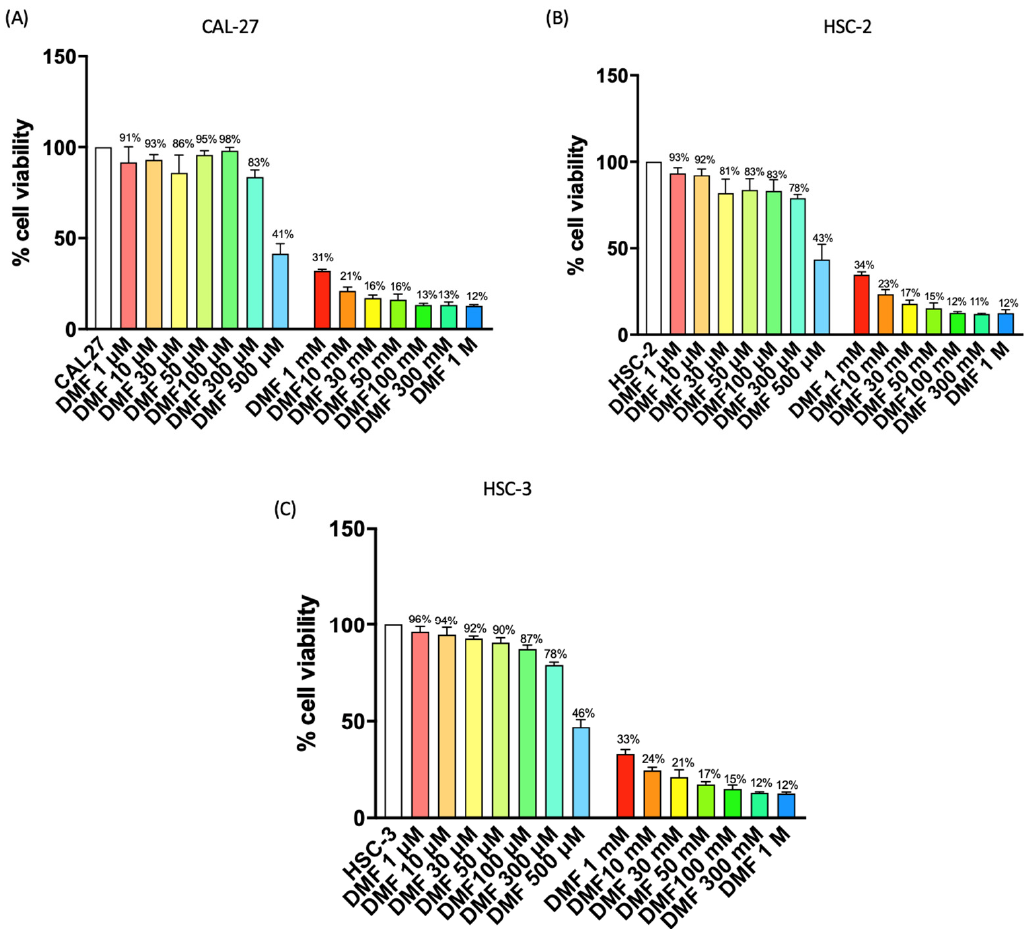
Figure 1. Effect of DMF on CAL27, HSC-2 and HSC-3 cell viability. DMF treatment at the concentrations of 500 μ M was able to significantly reduce cell viability by 41% on CAL27 cells ( A ), 43% on HSC-2 ( B ) cells and 46% on HSC-3 cells ( C ). DMF 1 mM was able to reduce cell viability by 31% on CAL27 cells, 34% on HSC-2 cells and 33% on HSC-3 cells. DMF 10 mM reduced cell viability by 21% on CAL27 cells, 23% on HSC-2 cells and 24% on HSC-3 cells.